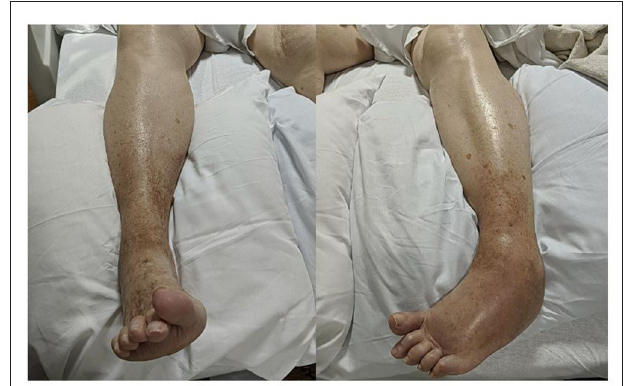
FIGURE 1 | Asymmetrical dystonic posturing on both sides (left more than right) with significant swelling and redness in the dorsum of the left foot.